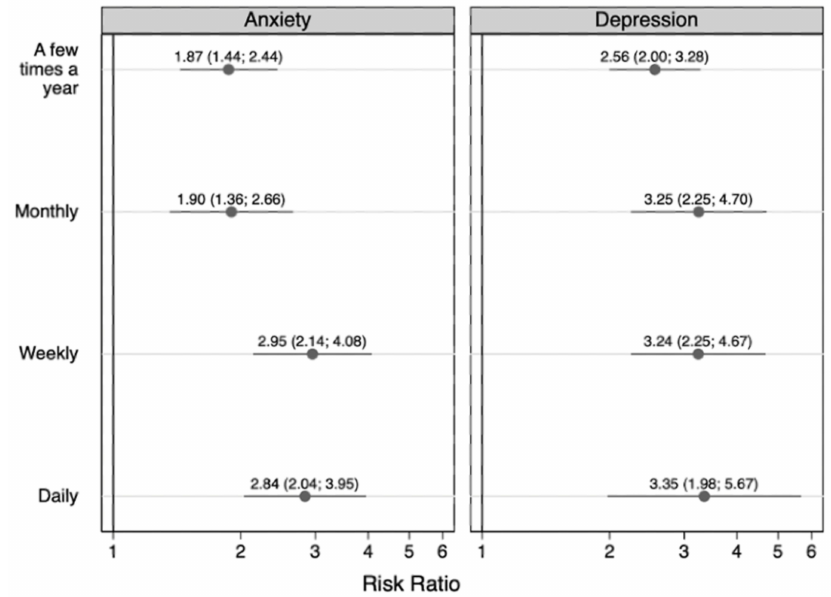
Figure 1. The association between having ever resided with someone with a substance use disorder and frequency of children’s anxiety and depression (n = 6642). Symbols indicate relative risk ratios and lines indicate 95% confidence intervals. The referent groups are children who never experienced anxiety and children who never experienced depression.